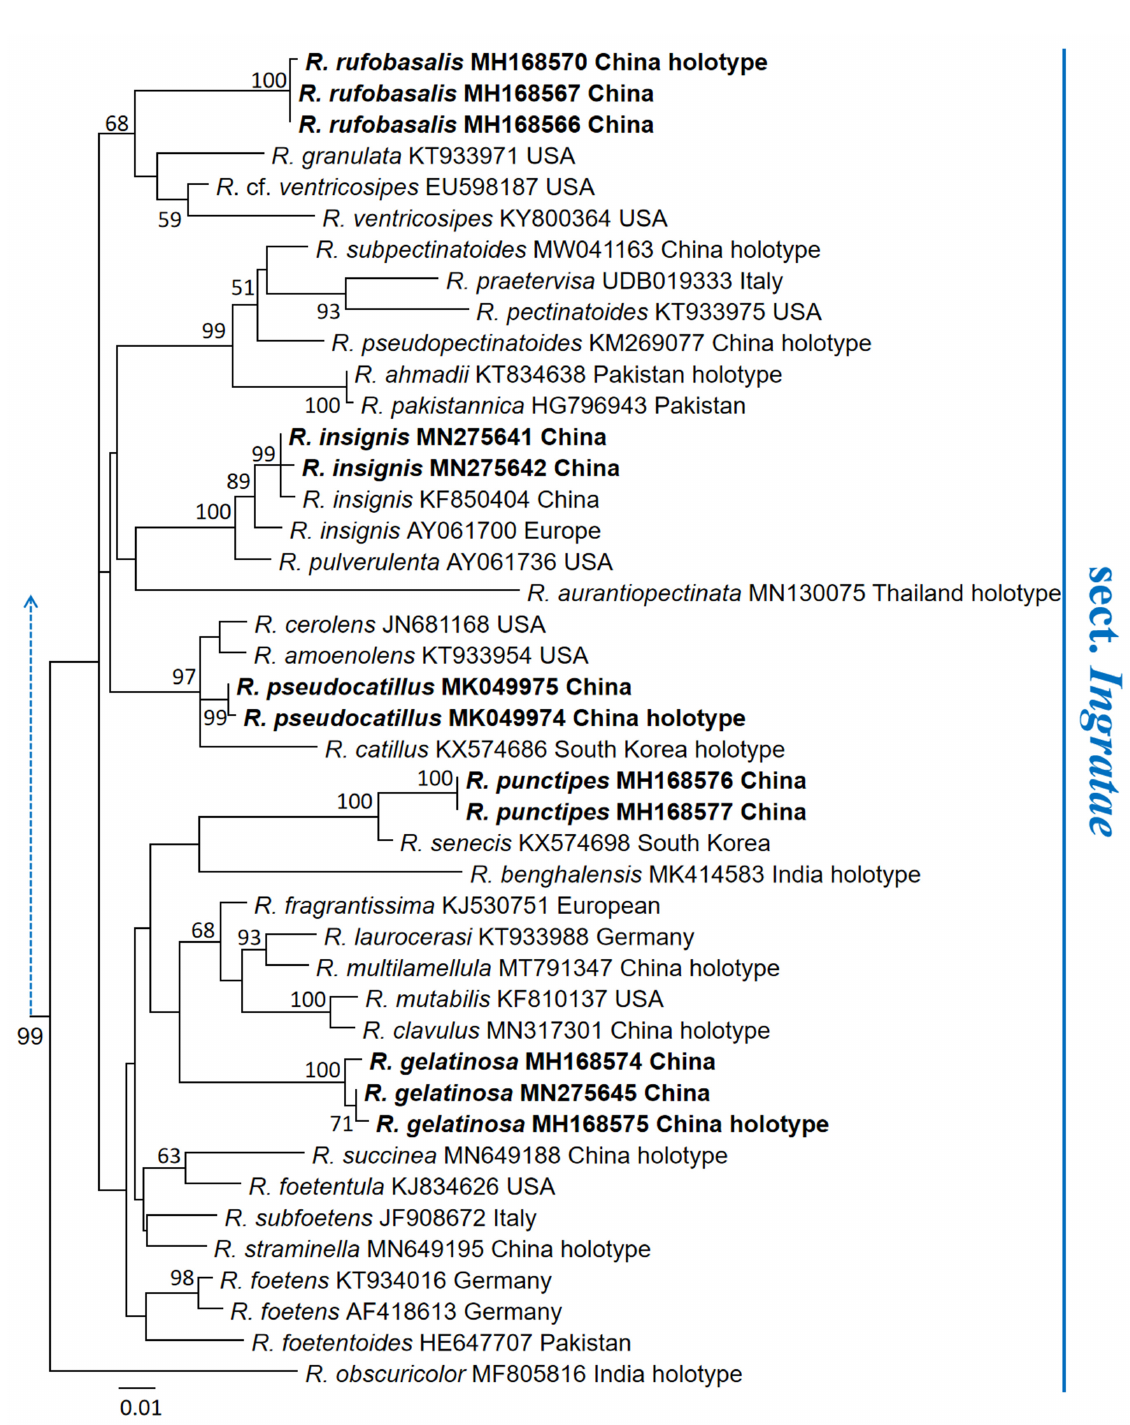
Fig. 1-3. Phylogram of sect. Ingratae Quel. Bootstrap values higher than 50% are shown above or below the branches. Species collected from Dinghushan Biosphere Reserve are shown in